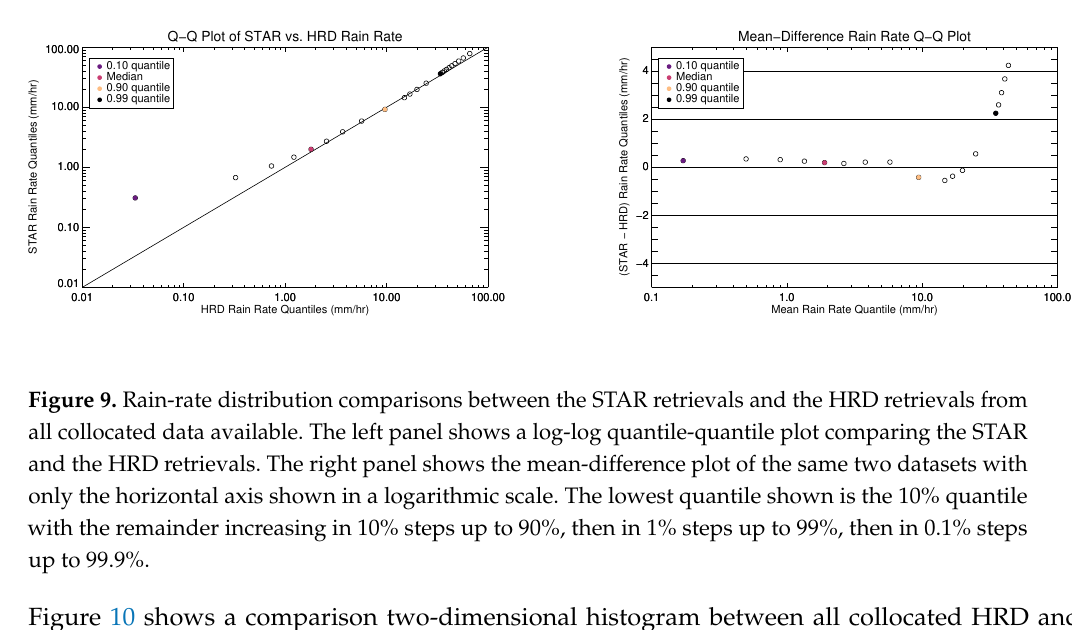
Figure 8. Two-dimensional histogram of the HRD rain rate vs. rain rate produced by the model developed in this manuscript from all collocated data available. The solid gray line shows the mean in each 1mmh − 1 bin on the horizontal axis.